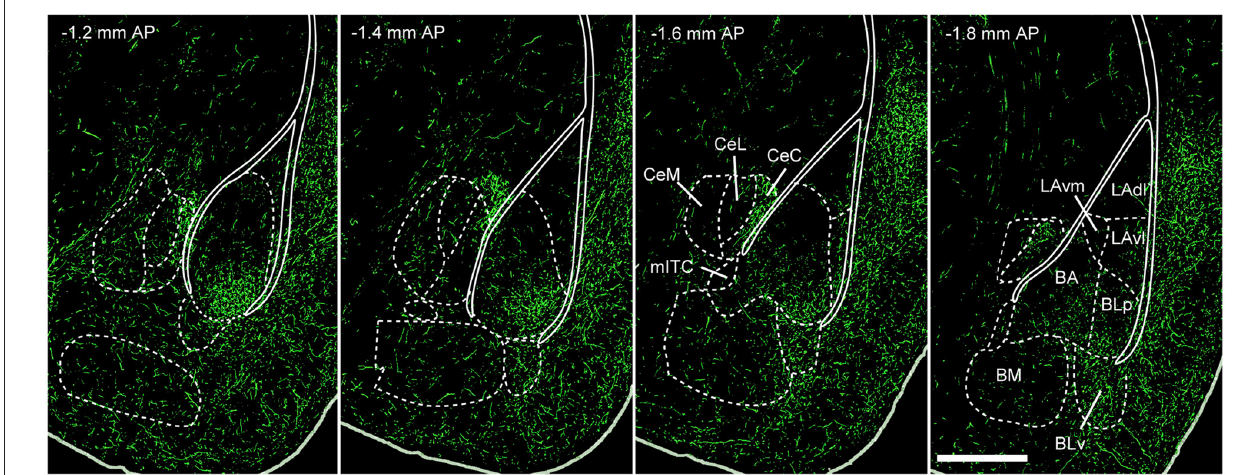
FIGURE 3 | 5-HT innervation of the mouse amygdala. Green fluorescent protein (GFP) expressed in 5-HTT + DRN neurons via injection of the Cre-dependent anterograde tracer rAAV2/1.hSynapsin.EGFP.WPRE.bGH in the DRN of SLC6A4-Cre (5-HTT-Cre) mice. This produces a pattern of innervation of the amygdaloid complex that is similar to the one previously described using antibodies for 5-HT or the 5-HTT. The densest innervation occurs in BA and BLp nuclei. Weaker innervation is observed in LA, BM and CeA, with the exception of CeC. Abbreviations: BA, basal amygdala; BLp, basolateral amygdala posterior portion; BLv, basolateral amygdala ventral portion; BM, basomedial amygdala; CeA, central nucleus of the amygdala; CeC, centrocentral amygdala; CeL, centrolateral amygdala; CeM, centromedial amygdala; LAdl, lateral amygdala dorsolater portion; LAvl, lateral amygdala ventrolateral portion; LAvm, lateral amygdala ventromedial portion; mITC, main intercalated cell cluster nucleus; AP, antero-posterior (distance from bregma); scale bar: 500 µ m. Adapted from: Allen Mouse Brain Connectivity Atlas (Oh et al., 2014), experiment 114155190. Website: © 2015 Allen Institute for Brain Science. Available from: